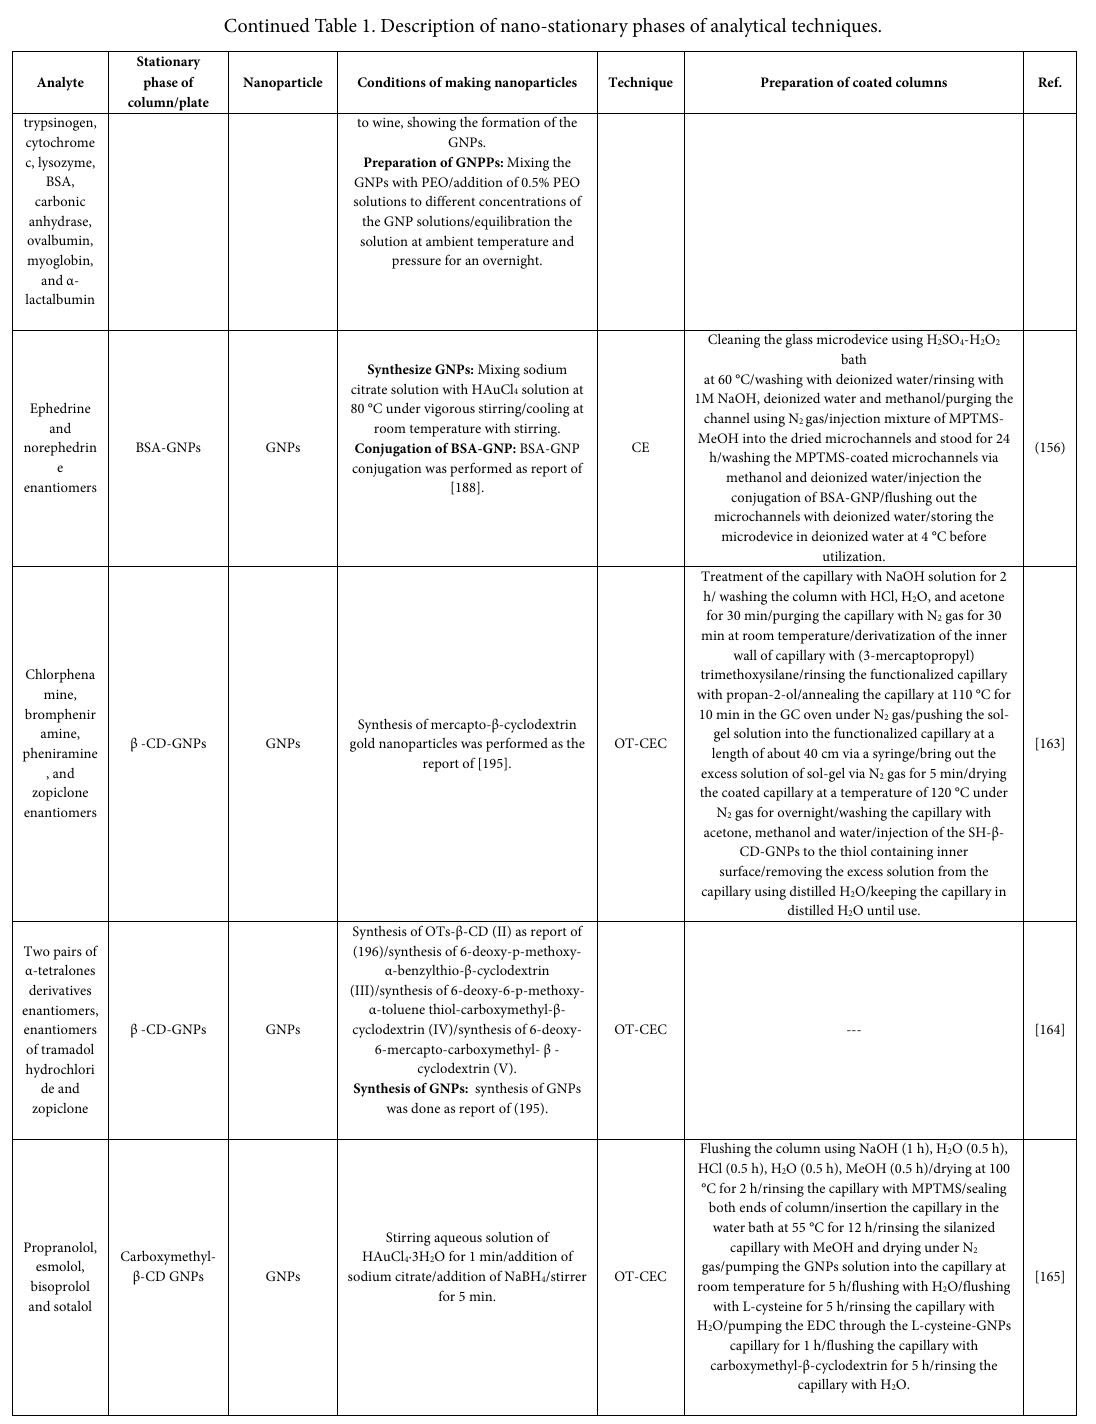
Cleaning the glass microdevice using H 2 SO 4 -H 2 O 2 bath Synthesize GNPs: Mixing sodium at 60 °C/washing with deionized water/rinsing with citrate solution with HAuCl 4 solution at 1M NaOH, deionized water and methanol/purging the 80 °C under vigorous stirring/cooling at channel using N 2 gas/injection mixture of MPTMS- room temperature with stirring. MeOH into the dried microchannels and stood for 24 CE GNPs Conjugation of BSA-GNP: BSA-GNP h/washing the MPTMS-coated microchannels via conjugation was performed as report of methanol and deionized water/injection the [188]. conjugation of BSA-GNP/flushing out the microchannels with deionized water/storing the microdevice in deionized water at 4 °C before utilization. Treatment of the capillary with NaOH solution for 2 h/ washing the column with HCl, H 2 O, and acetone for 30 min/purging the capillary with N 2 gas for 30 min at room temperature/derivatization of the inner wall of capillary with (3-mercaptopropyl) trimethoxysilane/rinsing the functionalized capillary with propan-2-ol/annealing the capillary at 110 °C for 10 min in the GC oven under N 2 gas/pushing the sol- Synthesis of mercapto-β-cyclodextrin gel solution into the functionalized capillary at a GNPs gold nanoparticles was performed as the OT-CEC [163] length of about 40 cm via a syringe/bring out the report of [195]. excess solution of sol-gel via N 2 gas for 5 min/drying the coated capillary at a temperature of 120 °C under N 2 gas for overnight/washing the capillary with acetone, methanol and water/injection of the SH-β- CD-GNPs to the thiol containing inner surface/removing the excess solution from the capillary using distilled H 2 O/keeping the capillary in distilled H 2 O until use. Synthesis of OTs-β-CD (II) as report of (196)/synthesis of 6-deoxy-p-methoxy- α-benzylthio-β-cyclodextrin (III)/synthesis of 6-deoxy-6-p-methoxy- α-toluene thiol-carboxymethyl-β- cyclodextrin (IV)/synthesis of 6-deoxy- GNPs OT-CEC --- [164] 6-mercapto-carboxymethyl- β - cyclodextrin (V). Synthesis of GNPs: synthesis of GNPs was done as report of (195). Flushing the column using NaOH (1 h), H 2 O (0.5 h), HCl (0.5 h), H 2 O (0.5 h), MeOH (0.5 h)/drying at 100 °C for 2 h/rinsing the capillary with MPTMS/sealing both ends of column/insertion the capillary in the water bath at 55 °C for 12 h/rinsing the silanized Stirring aqueous solution of capillary with MeOH and drying under N 2 Carboxymethyl- HAuCl 4 ·3H 2 O for 1 min/addition of gas/pumping the GNPs solution into the capillary at β-CD GNPs GNPs OT-CEC sodium citrate/addition of NaBH 4 /stirrer room temperature for 5 h/flushing with H 2 O/flushing for 5 min. with L-cysteine for 5 h/rinsing the capillary with H 2 O/pumping the EDC through the L-cysteine-GNPs capillary for 1 h/flushing the capillary with carboxymethyl-β-cyclodextrin for 5 h/rinsing the capillary with H 2